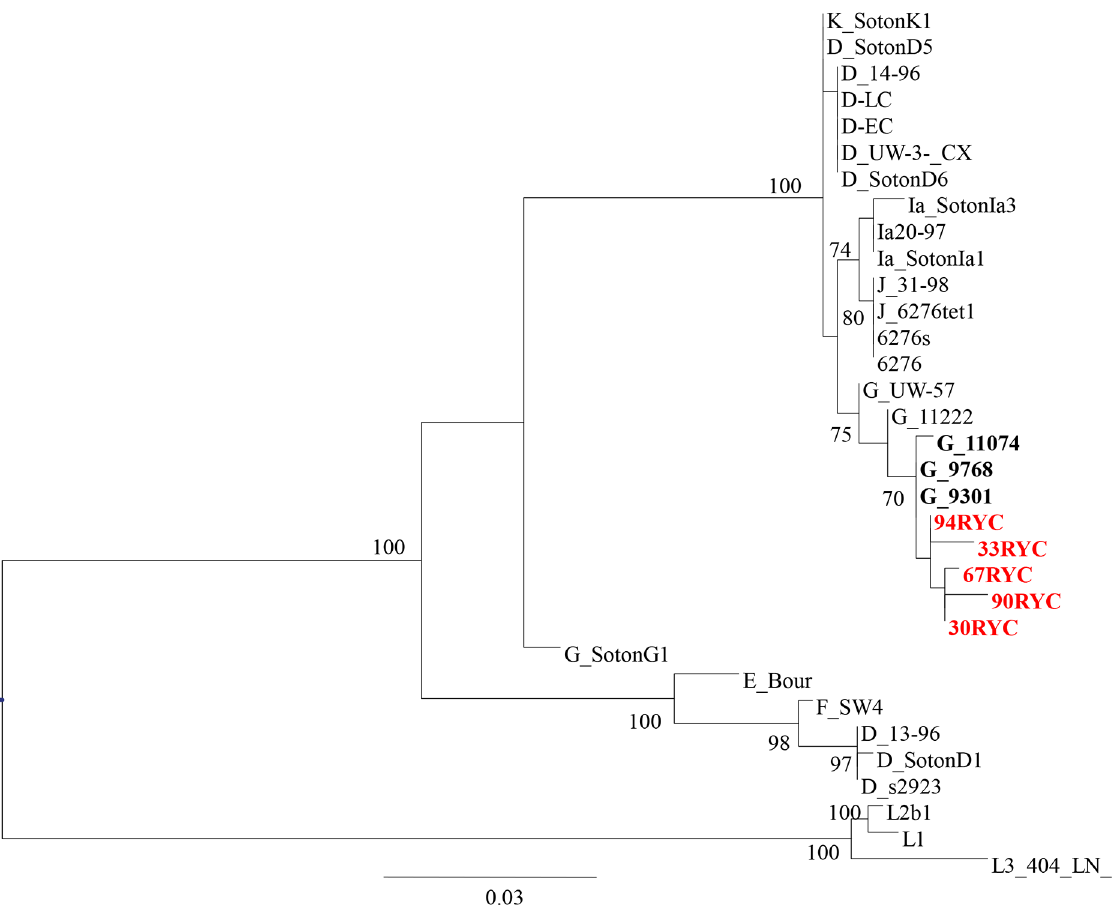
Fig 3. Maximum likelihood analysis of concatenated rs2-tarP-incEF-pmpH genes. Red letters correspond to putative pmpH-recombinant variants described in this study. Bold letters correspond to genotype G strains described in Seattle. The general time reversible plus proportion of invariable sites and gamma distribution model (GTR+ I+G) implemented in PhyML software was used. Numbers indicate bootstrap values based on 1000 replicates (%).